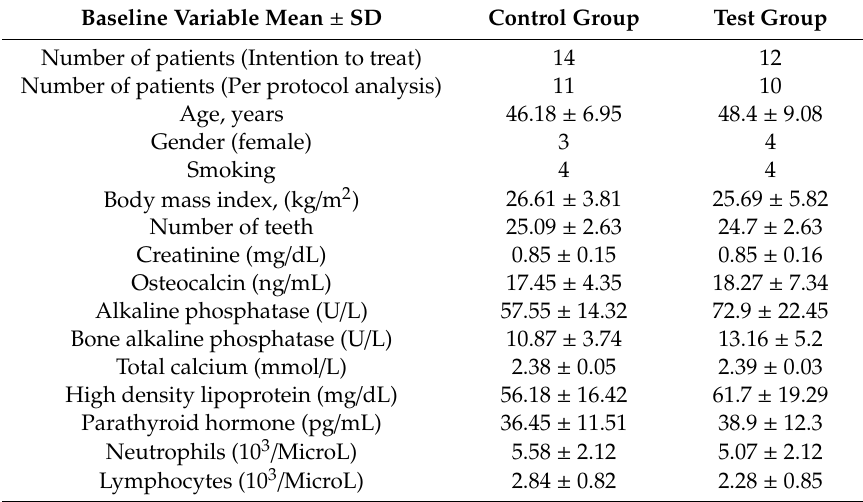
Table 2. Baseline